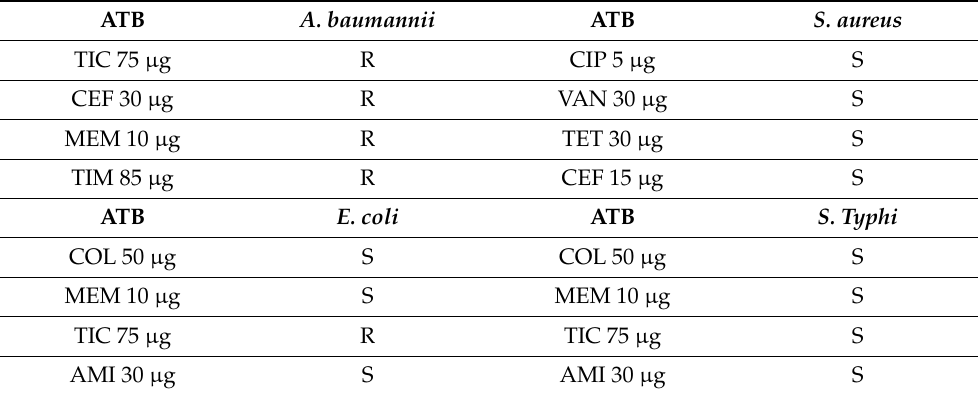
Table 3. The test for the sensitivity of bacterial strains to certain antibiotics. ATB ATB